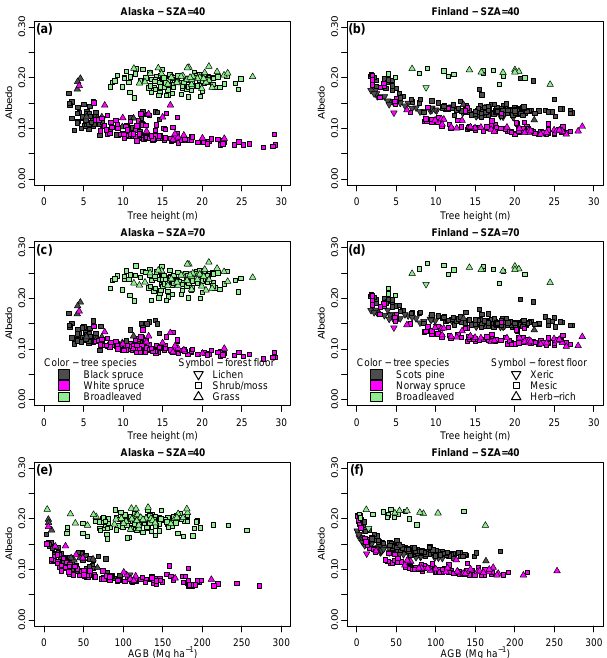
Figure 4. Forest black-sky albedo as a function of tree height (a– d) and AGB (e–f) . Relations to tree height are shown for two SZAs, 40 ◦ (a–b) and 70 ◦ (c–d) , representing solar noon at midsummer and the annual average in the study regions. Left hand column shows the results for the Alaskan data, and right hand column for the Finnish data. The figures show only monospecific plots, i.e., plots in which the basal area proportion of one of the species exceeded